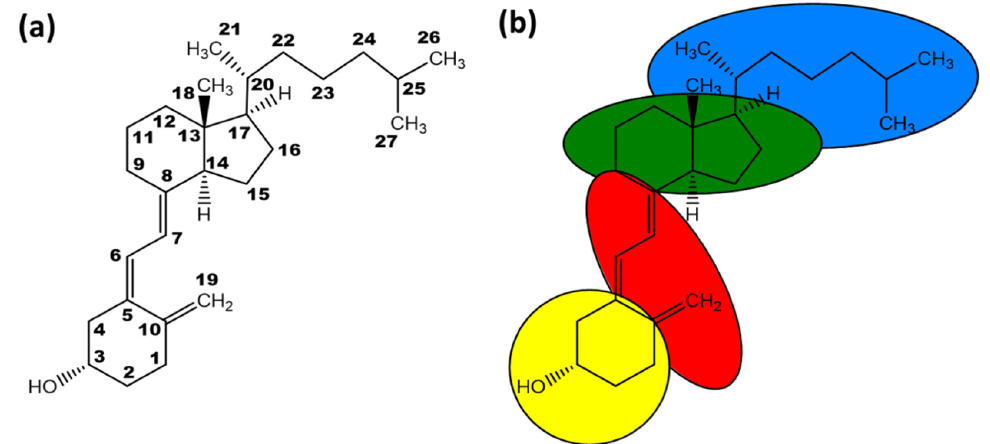
Figure 1. Structural elements of vitamin D 3 . ( a ) Structural formula of vitamin D 3 with the canonical numbering of the carbon atoms. ( b ) The four structural elements of vitamin D 3 are highlighted: A-ring (yellow), conjugated triene region (red), C- and D-ring (green), and sidechain (blue). An overview of the chemical structure of currently known isoforms of vitamin D is given in Figure 2.